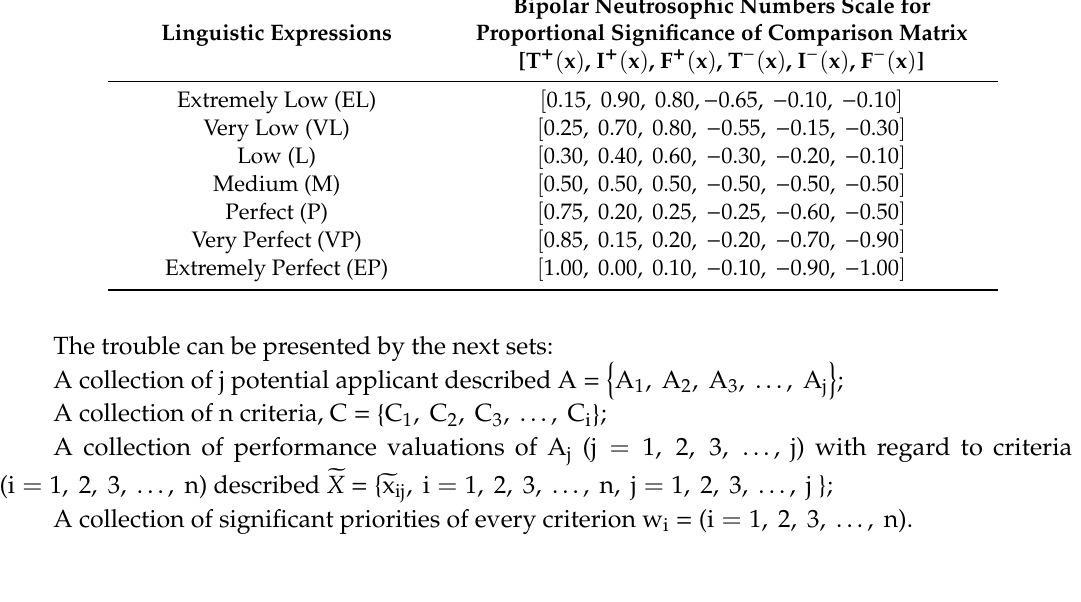
Table 2. Linguistic expressions for valuation. Bipolar Neutrosophic Numbers Scale Linguistic Expressions